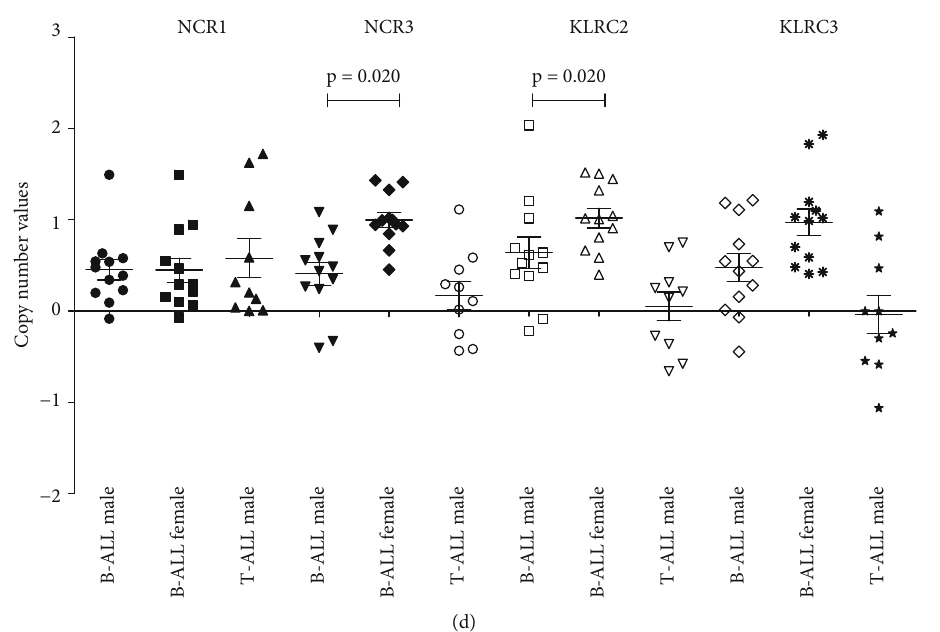
Figure 1: Copy number variations in ALL patient. (a) Copy number ampli fi cation/deletion in inhibiting and activating NK receptor in T-ALL male ( n = 6 ) normalized to normal male controls ( n = 4 ) using NGS method. Broken line indicates normal gene copy number of 2. (b – d) Copy number ampli fi cation/deletion of the same genes in T-ALL male ( N = 10 ) and B-ALL patients ( N = 12 males and 12 females) normalized to healthy individuals of same sex ( N = 12 males and 12 females) using quantitative-PCR method (q-PCR). An initial normalization with reference gene GAPDH was performed. Horizontal bars showed p values of the Mann-Whitney U tests to compare frequencies in copy number ampli fi cation between two groups. p < 0 : 05 was considered signi fi cant. Data presented in mean ± standard deviation